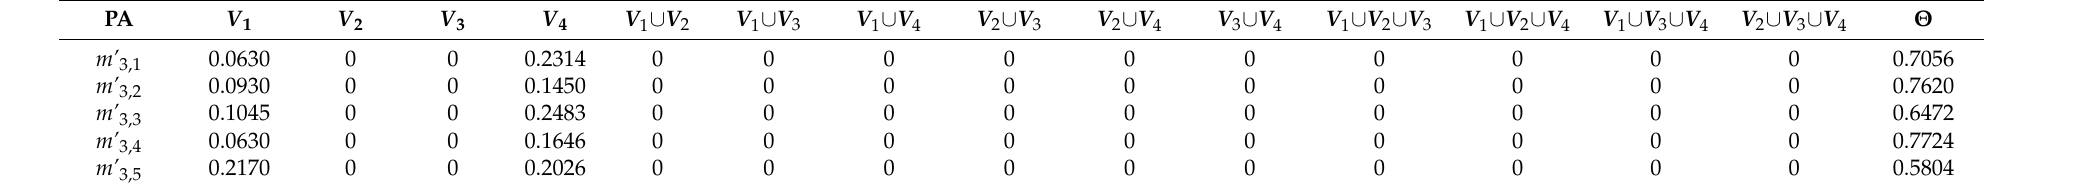
Table 13. Probability assignments of without crack-oblique crack sub-classifier for an image of a transverse crack.